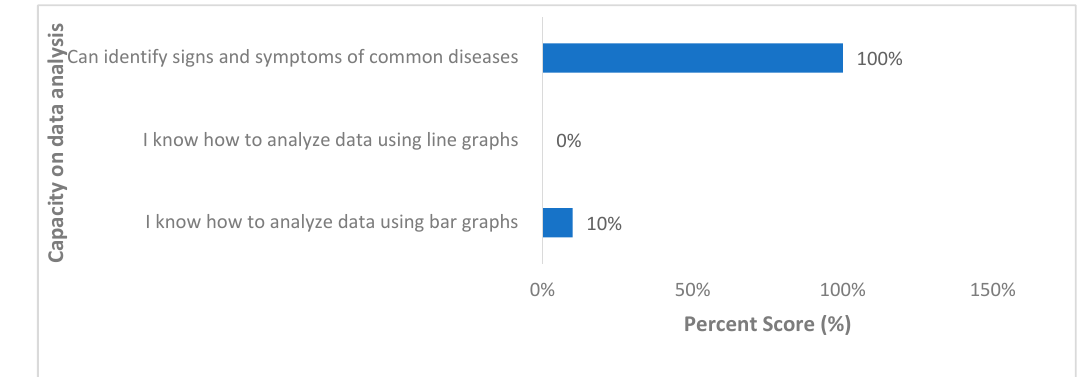
Int. J. Environ. Res. Public Health 2021 , 18 , x FOR PEER REVIEW Figure 3. Data analysis capability of village health team members across all 10 villages in the Kween District, Uganda, 2020.